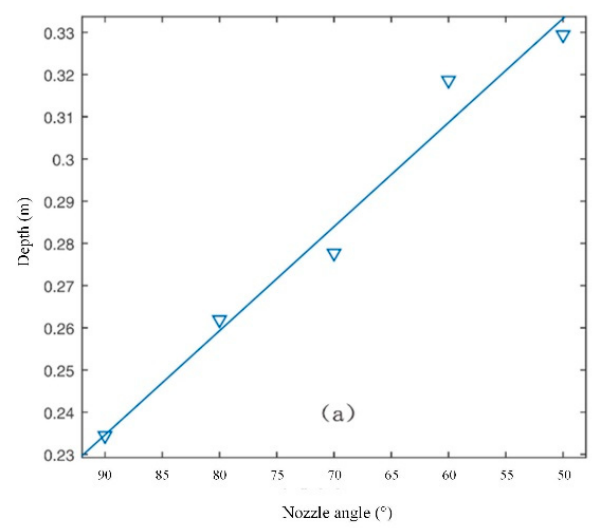
Figure 12. The correlation curve of scour depth and jet angle.